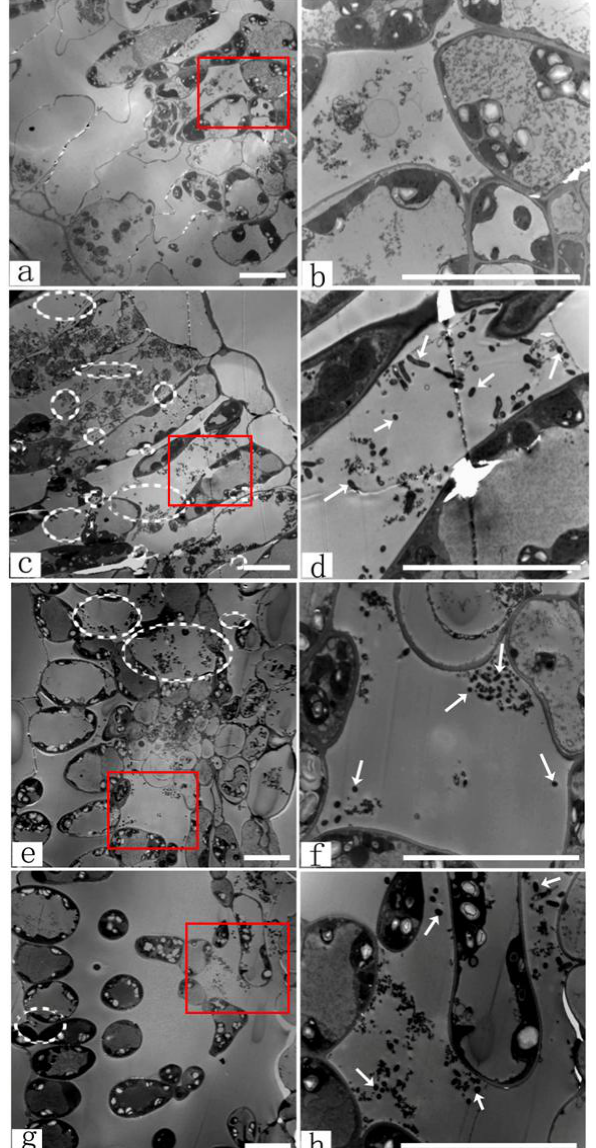
Figure 5. Transmission electron micrographs of the different leaf ages with Agrobacterium invasion in intercellular spaces. Leaf explants were infected with Agrobacterium at OD ranging from 0.8 to 1.0 and infected for 20 min to 30 min. The leaf explants were cut transversely. ( a ) and ( b ) Uninfected leaf as the control; ( c ) and ( d ) 30-day-old leaf explant; ( e ) and ( f ) 60-day-old leaf explant; ( g ) and ( h ) 90-day-old leaf explant. In c – h , Agrobacterium invasion into the intercellular space was indicated by white circles and arrows. The magnified images of the boxes in the left column ( a , c , e , g ) were placed in the right column ( b , d , f , h ), respectively. Scale bar 20